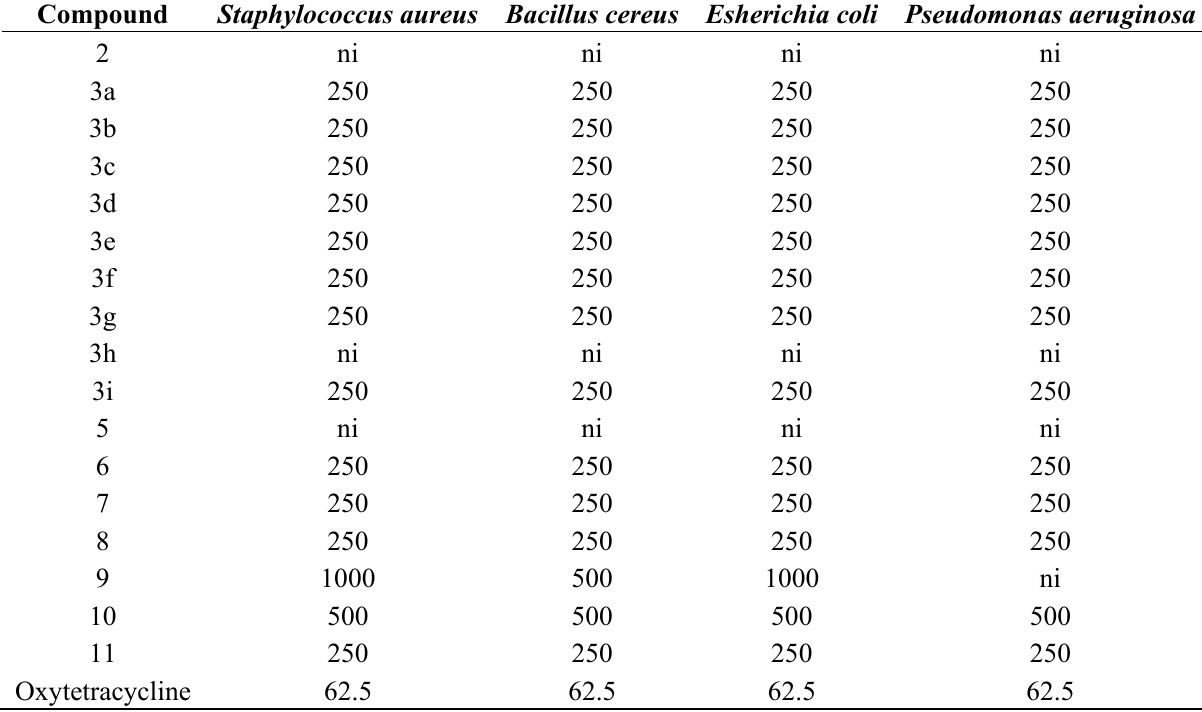
Table 1. Antibacterial activity in vitro of the synthesized compounds (MIC, µg/mL). Compound Staphylococcus aureus Bacillus cereus Esherichia